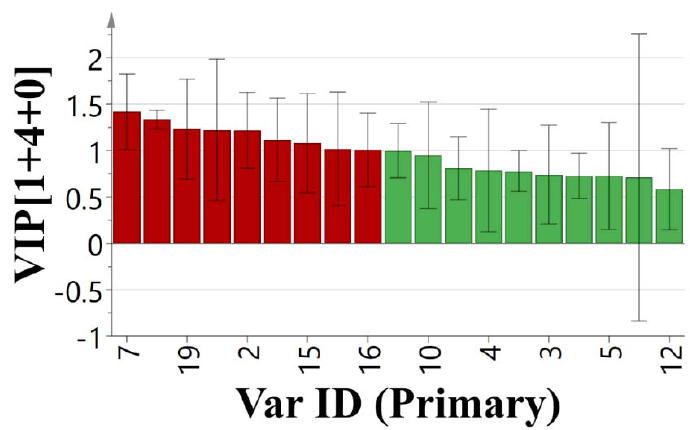
Figure 5. Graphical representation of OPLSR model—VIP plot.